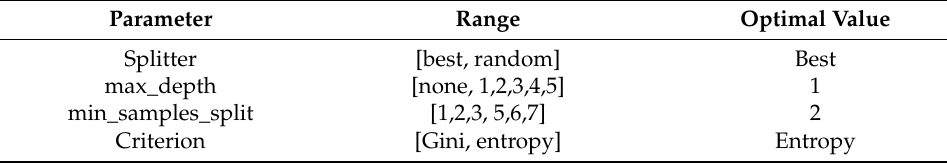
Table A5. Hyperparameter tuned for the decision tree classifier.